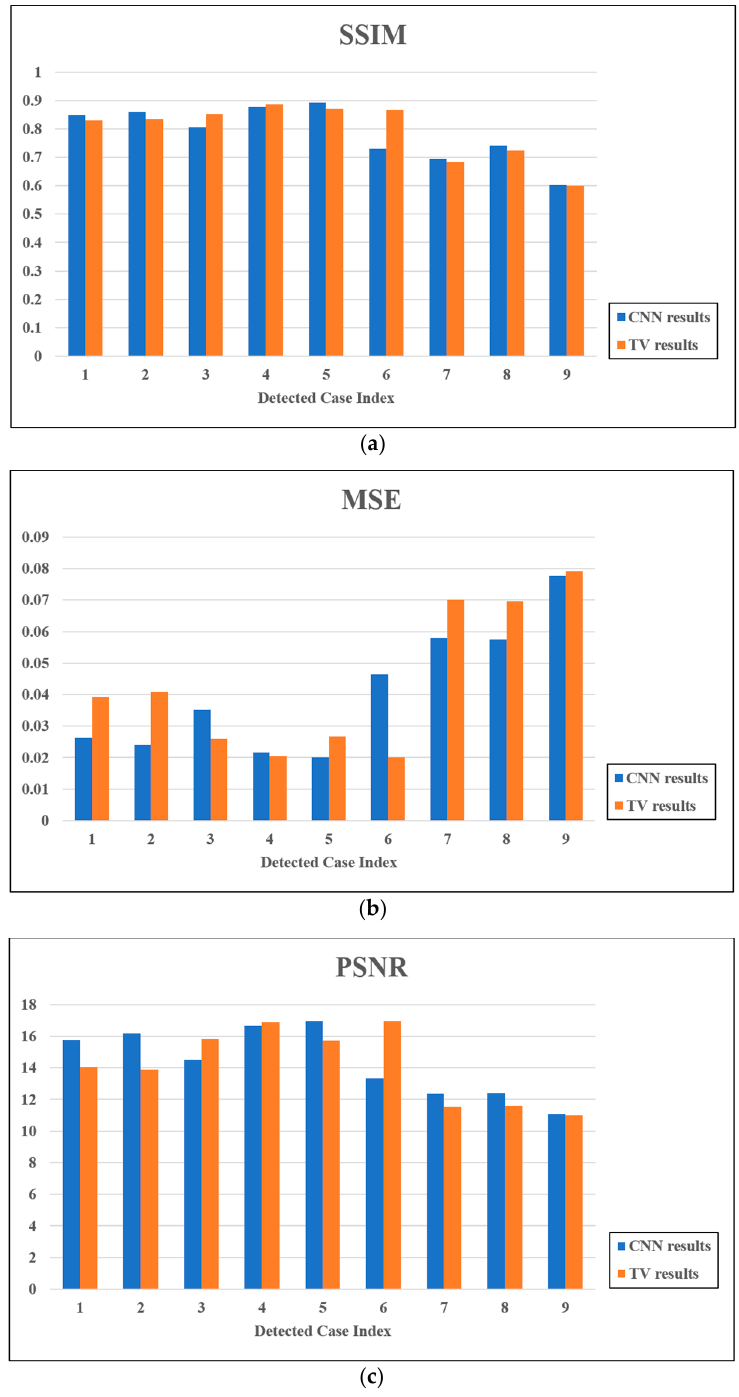
Figure 11. ( a ) SSIM (structural similarity) plot ( b ) MSE (mean squared error) plot ( c ) PSNR (peak signal-to-noise ratio) plot for 9 reconstruction cases by CNN and TV (total variation).